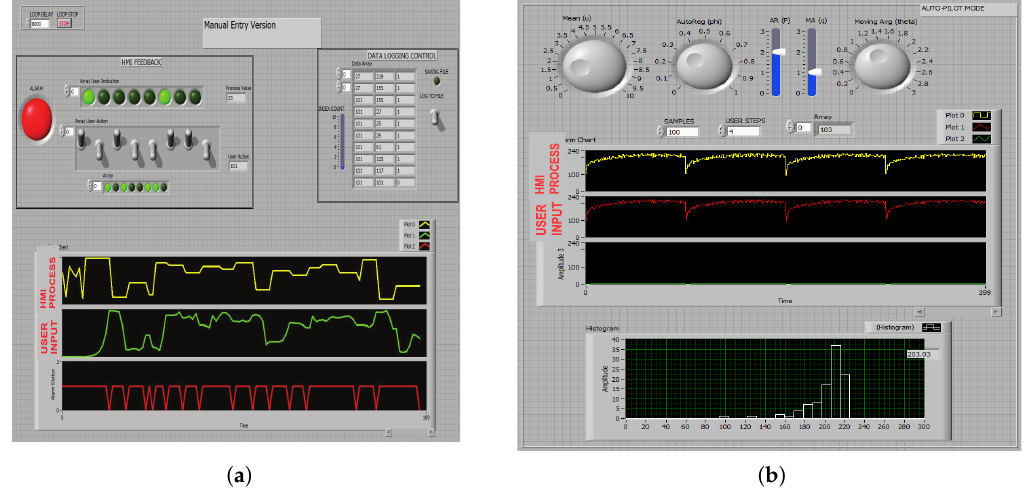
Figure 13. ( a ) ht -MI application in Manual mode: Process values are generated using a first-order AR( α ), MA( β ) process with Gaussian noise ( (cid:101) t ), periodic trend and seasonal components Equation (14). Manual mode: Process values are displayed via array of lamp indicators. The user tracks indication patterns by manually setting toggle switches in same pattern until alarm indication (red lamp) goes off while user actions are logged each time step. ( b ) ht -MI application in Auto Pilot mode: In Auto-Pilot mode, user tracking response to process values is modelled using a PI controller with random proportional gain. Human Machine Interface (HMI) process and user response is captured as time series